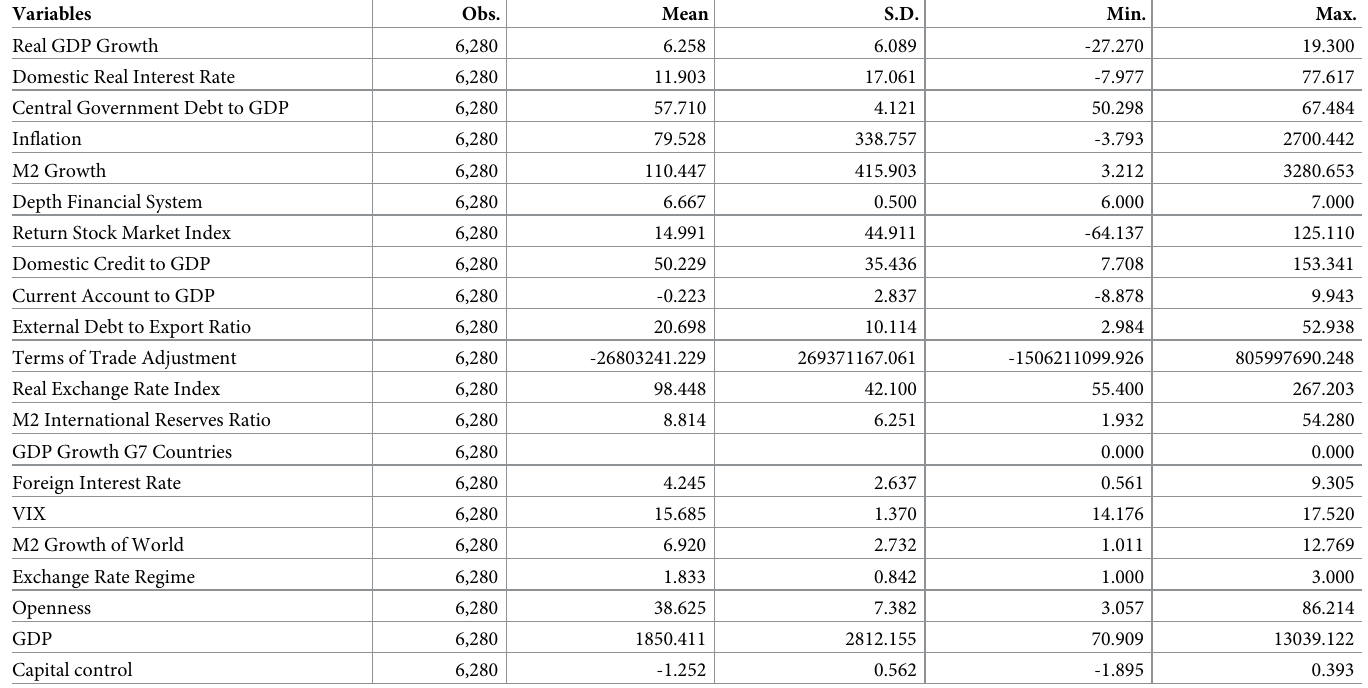
Table 2. Emerging summary